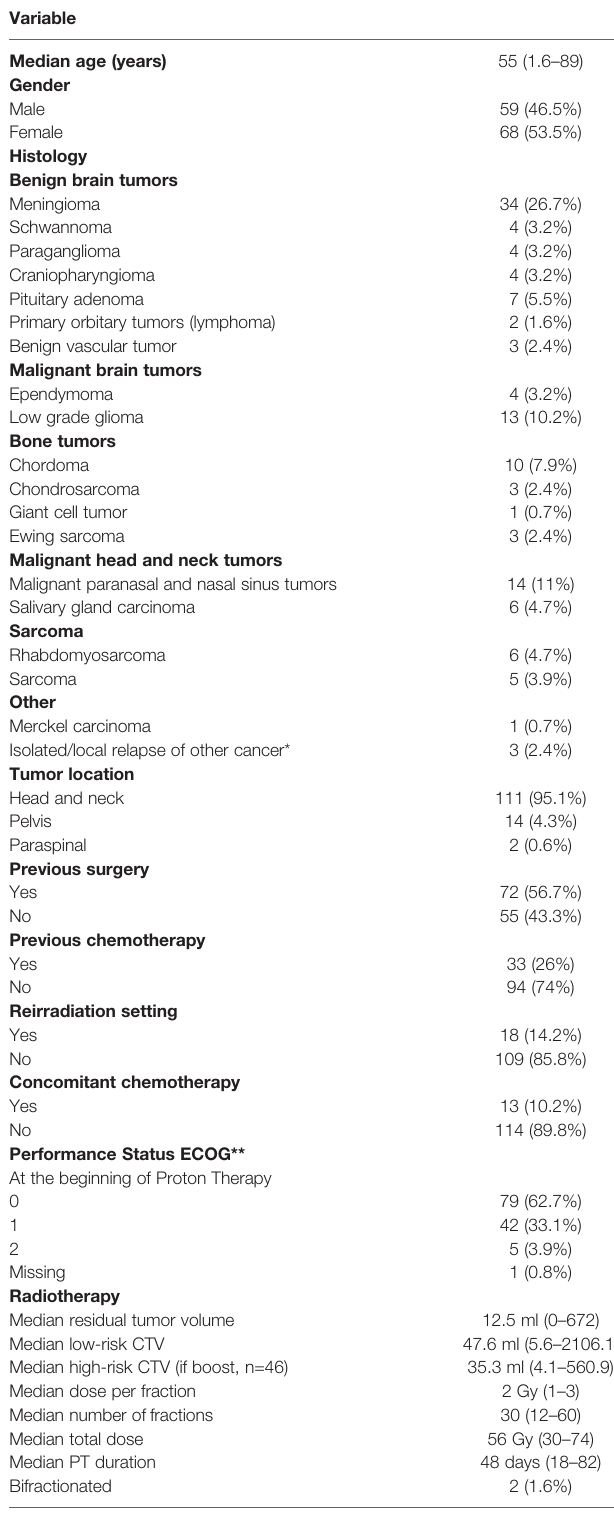
TABLE 1 | Patient and treatment